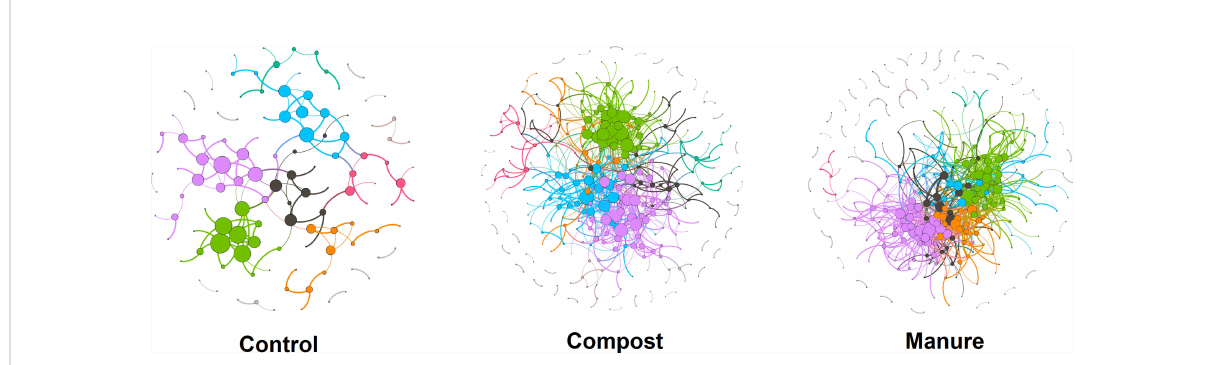
FIGURE 3 Microbial networks under three organic N treatments. Networks are built using the random matrix theory. Nodes represent ASVs and links indicate signi fi cant correlation. Modules are randomly colored. Detailed topological features of networks are shown in Table